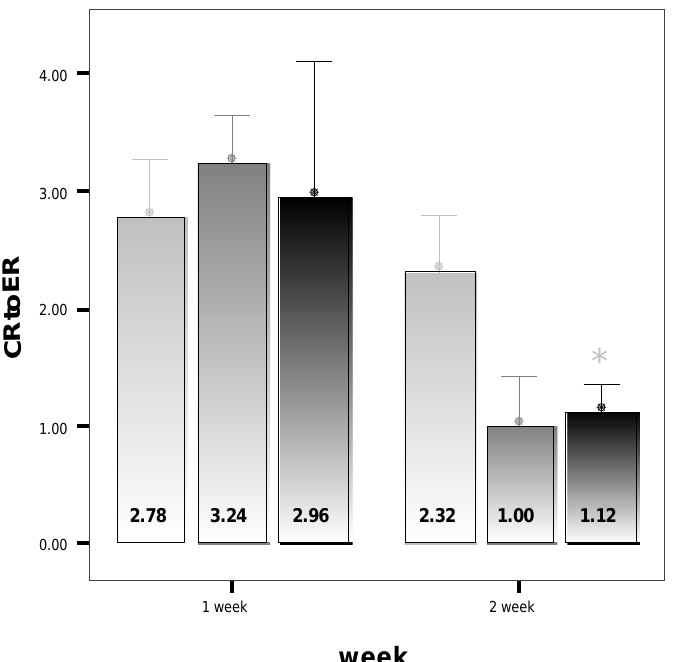
Figure 11. Contraction rate (CR) to epithelialization rate (ER) ratio for the two treatments and the control at 1 and 2 weeks.